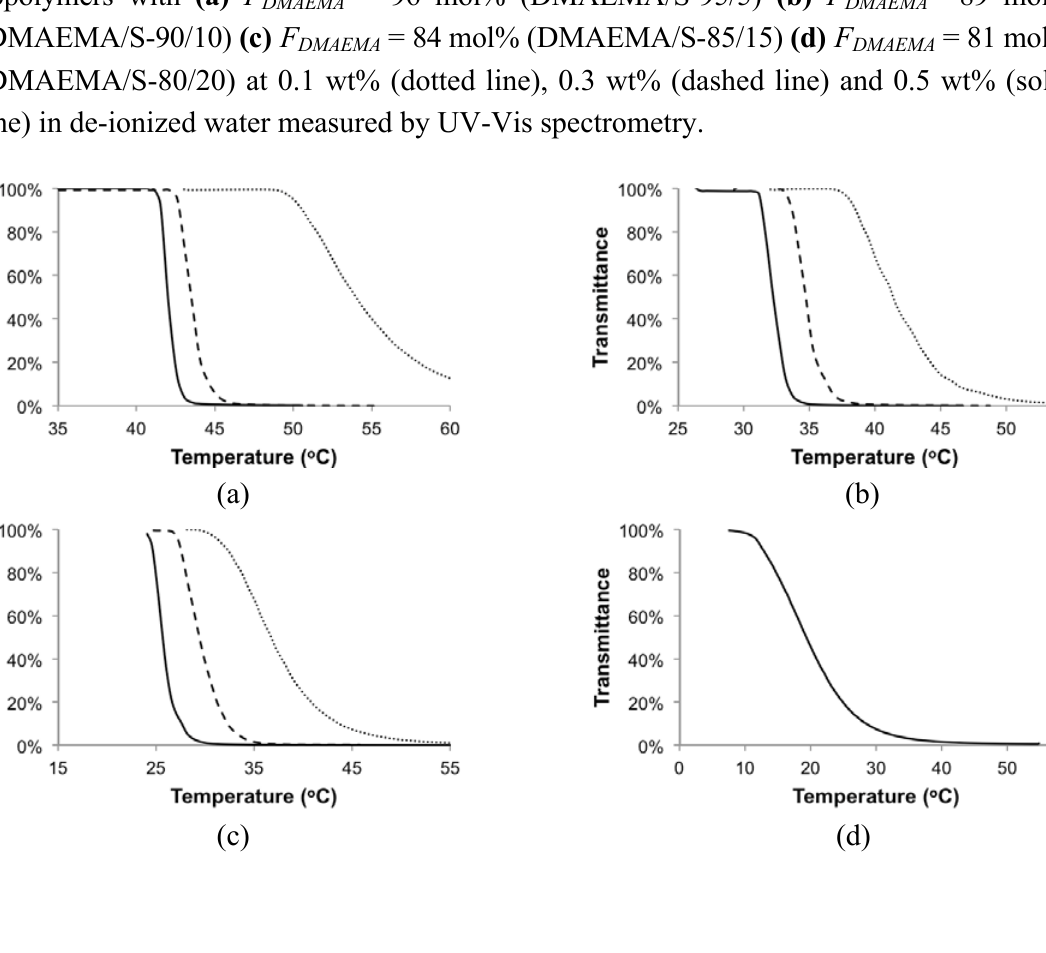
=89 mol% DMAEMA = 81 mol% DMAEMA